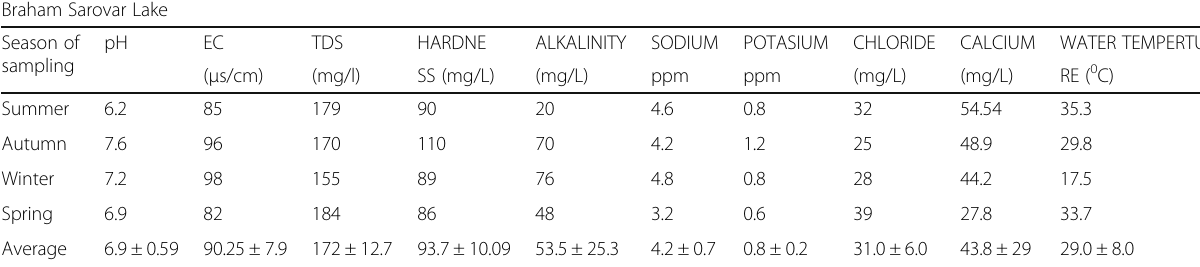
Table 9 Physico-chemical Parameters of Braham Sarovar Braham Sarovar Lake Season of sampling